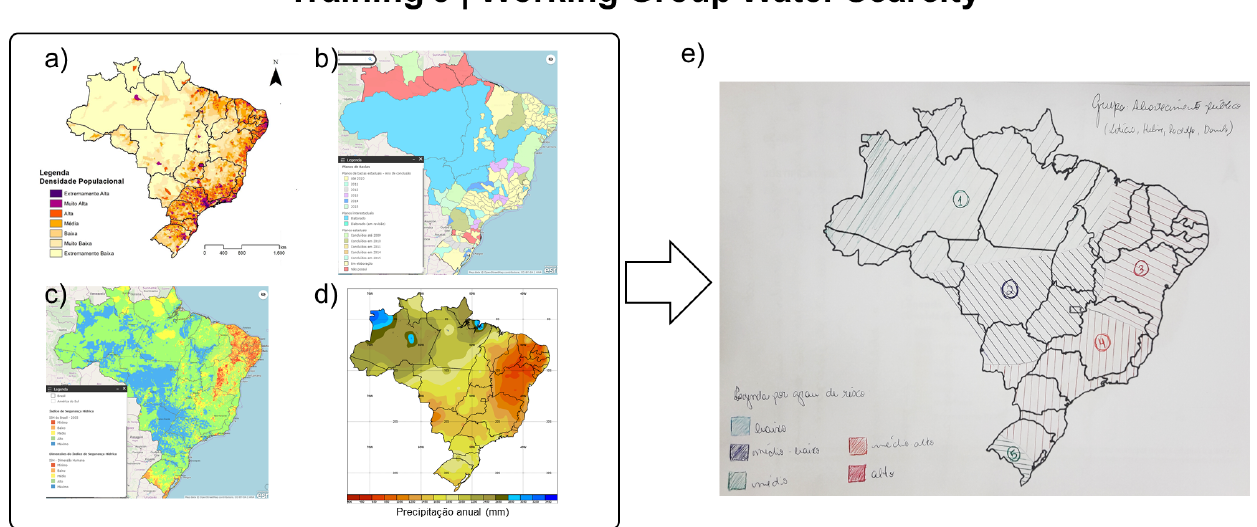
Figure A13. Package of maps used in the third training for mapping climate risk associated with water scarcity. The maps illustrate (a) pop- ulation density (MMA, 2017), (b) stage of implementation of the water resources planning (Planos de Recursos Hídricos, 2020), (c) water security index (Planos de Recursos Hídricos, 2020), (d) annual rainfall (Normais climatológicas do Brasil, 2020), and (e) the climate risk map drawn by the participants.